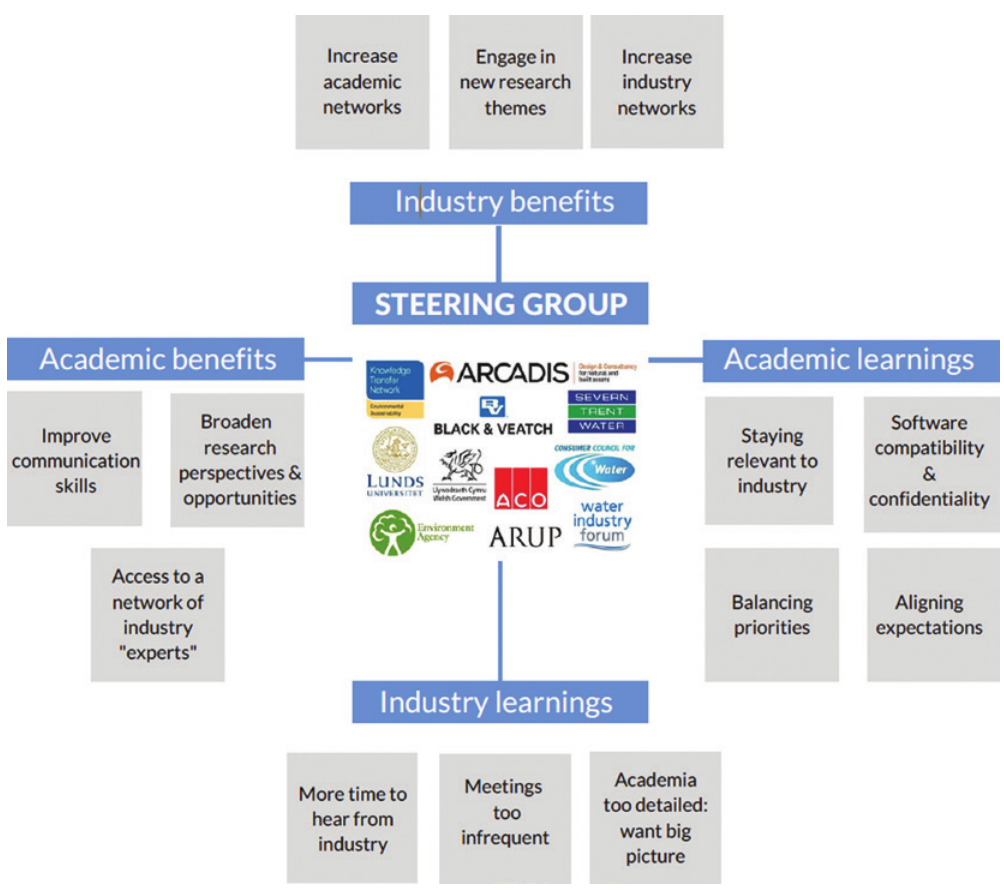
figure 2: Review of the steering group with benefits and learnings of industry and academics working